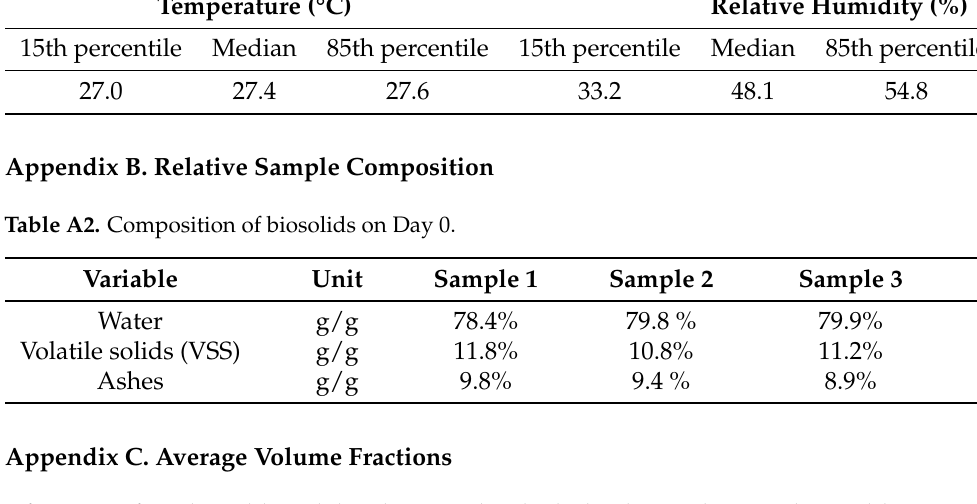
Table A3. Average volume fractions of voids and biosolids, plus gravel in both the deposit layer and gravel layer. Computations were performed for a ROI of